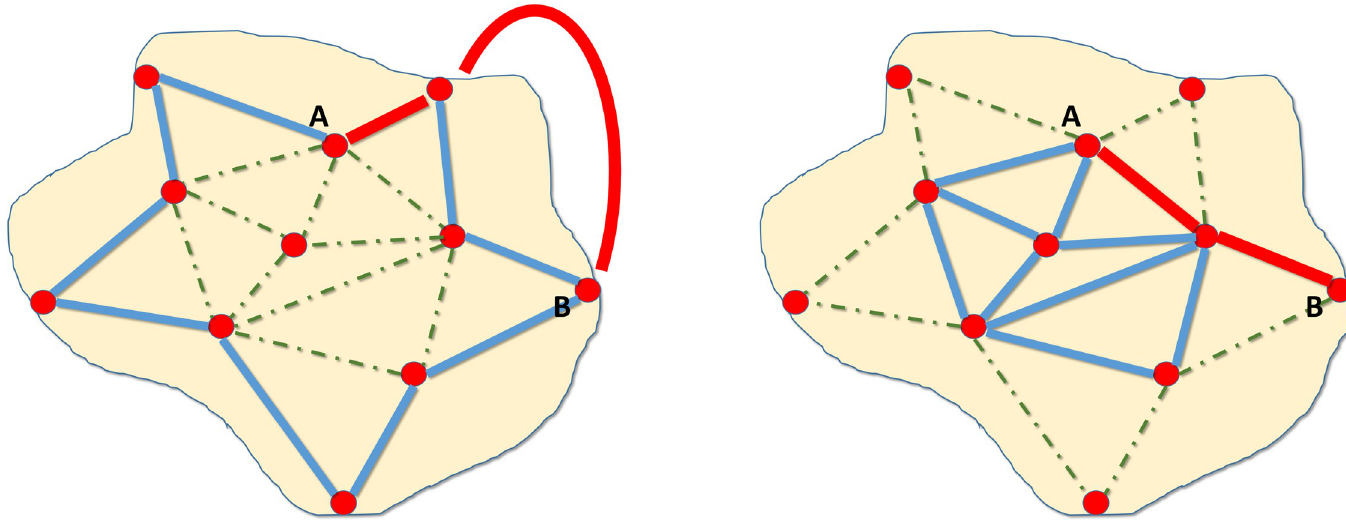
Fig 6. Relative advantages of maritime transport over land transport and development of the road network. Fig 6A) Road network with advantages in ship transportation. Fig 6B, Road network with advantages in road transportation. The blue lines represent the main roads, and the green dashed lines the secondary roads. The red lines show the optimal routes between A and B depending on the cost advantages of the means of transport. Source: Own elaboration.